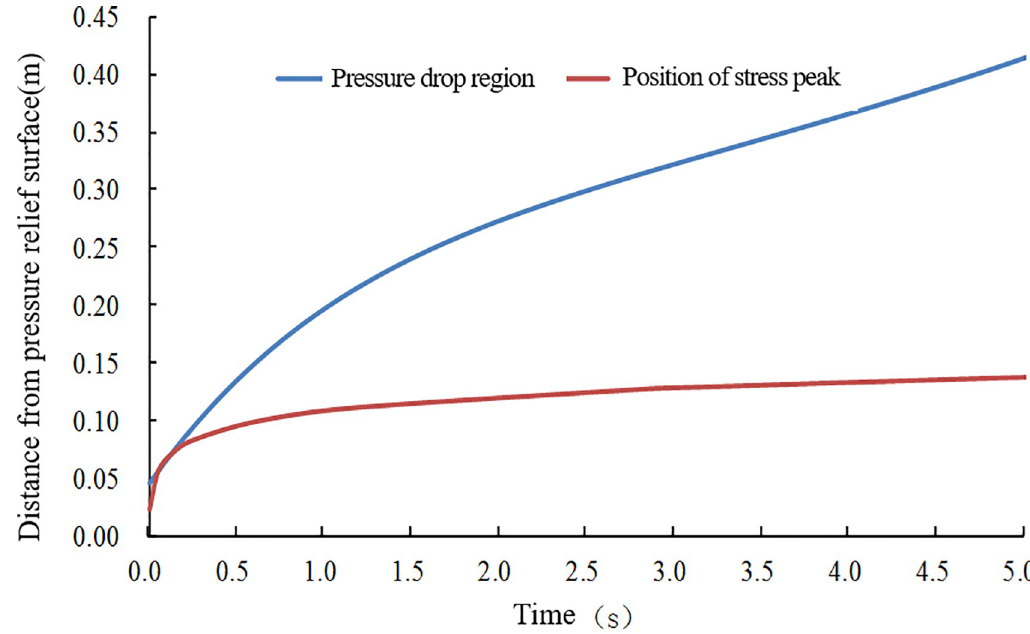
Fig 13. Calculation results of the peak tensile stress and pressure relief range at different times.